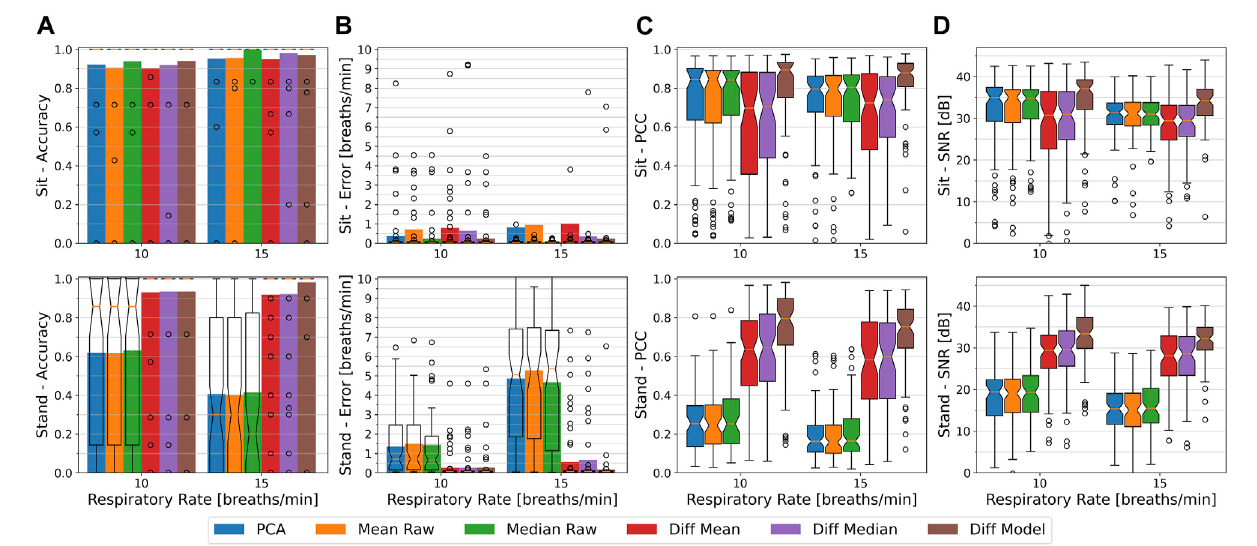
FIGURE8| From (A – D) :Therespiratoryrateaccuracy,errorsinbreathperminute,PearsonCorrelationCoef fi cientw.r.t.thegroundtruthsignal,andsignaltonoise ratioofthedifferentmethodsat thechest.Plotsareseparatedfromtoptobottombythesittingand standingconditionandbytherespiratoryrateof10 bpmor15 bpm, with all distances (1 – 4 m) combined. Accuracy and error metrics use a Fast Fourier Transform window with a length of 48 s. The colored bars show the averages, while overlayboxplotsshowmedian(middleparts)andwhiskersmarkingdatawithin1.5IQR.Thehigherrespiratoryrateshowaslightlybetteraccuracyoverallmethods when sedentary, but a lower signal quality (PCC and SNR values) on both